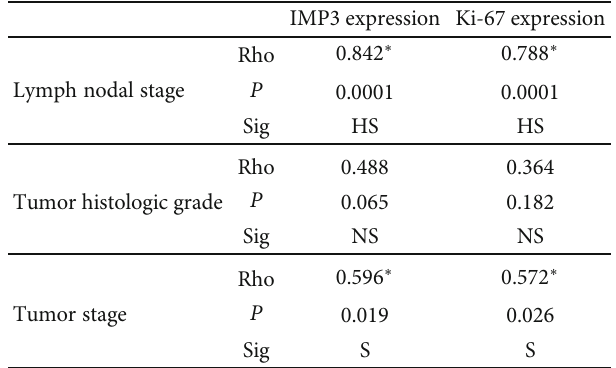
Table 6: Correlation between IMP3 and Ki-67 expression and clinicopathological parameters of SCC